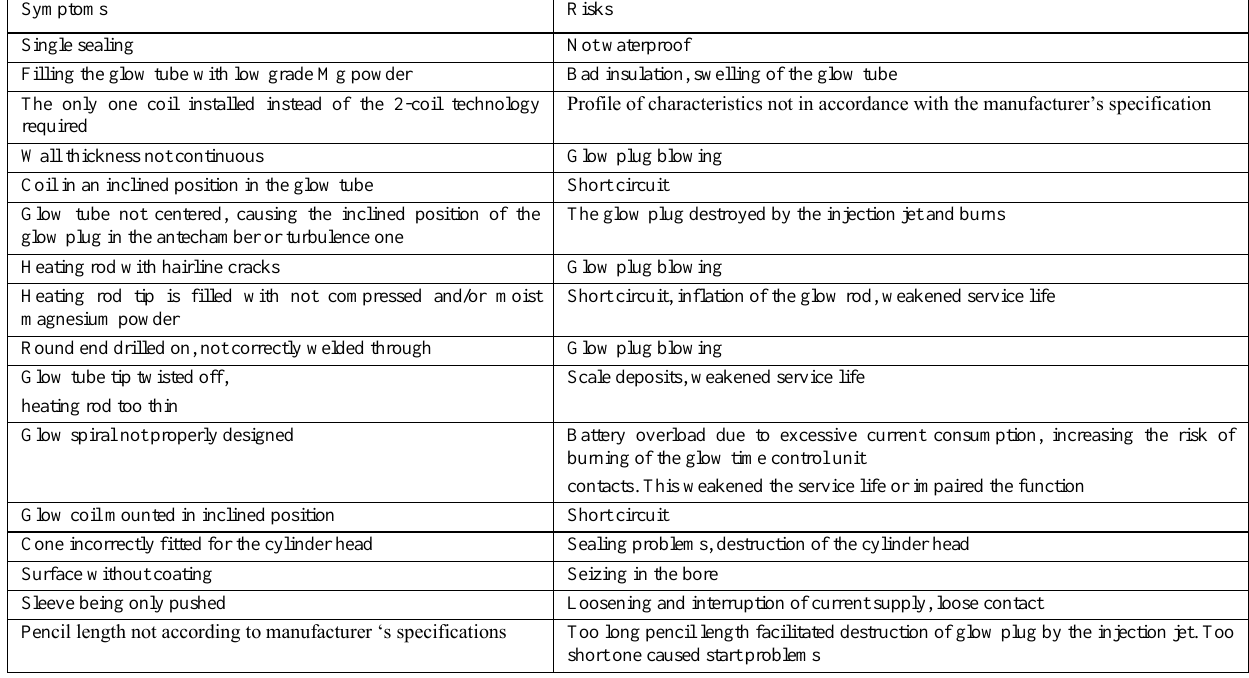
Fig. 4. A glow plug failure due to a melting heater element resulted from the thermal overload for the glow plug used in the 2009 Opel Movano 2.5 CDTI engine. Source: own elaboration Table 6. The symptoms and risks of low-quality glow